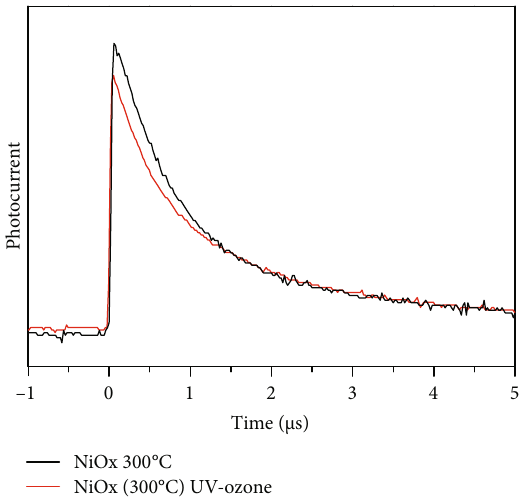
Figure 6: The transient photocurrent curves of the perovskite solar cell based on 300 ° C annealed NiOx with and without UV-ozone